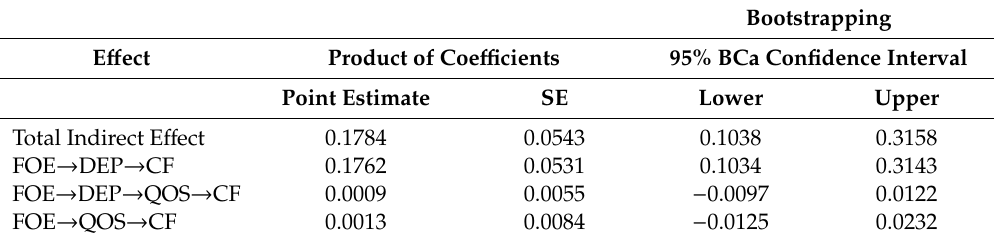
Table 3. Comparisons of indirect e ff ects and specific indirect e ff ects of frequency of exercise on cognitive function. Bootstrapping 95% BCa Confidence E ff ect Product of Coe ffi cients Interval Point Estimate SE Lower Upper Total Indirect E ff ect 0.0428 0.0091 0.0265 0.0621 FOE → QOS → CF 0.0005 0.0030 -0.0053 0.0070 FOE → QOS → DEP → CF 0.0036 0.0014 0.0014 0.0069 FOE → DEP → CF 0.0387 0.0085 0.0235 0.0567 Specific Indirect E ff ect Contrast Definitions Path 1 / Path 2 − 0.0350 0.0082 − 0.0525 −